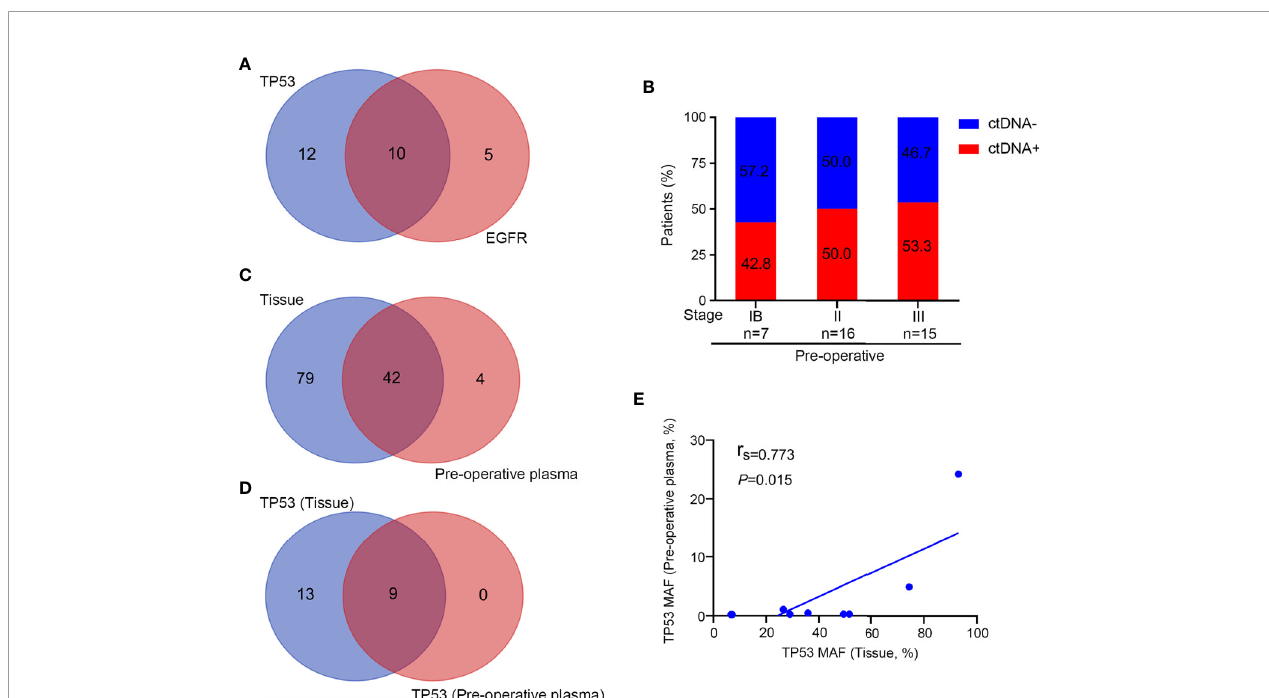
FIGURE 2 | NGS analysis of tissue and preoperative plasma samples. (A) TP53 and EGFR mutation detections in tissue samples. (B) Preoperative detection of ctDNA in different disease stages. (C) The number of detected mutations in tissue and preoperative plasma samples. (D) TP53 mutation detections in tissue and preoperative plasma samples. (E) The association of the mutant allele fraction (MAF) in tumor tissue samples and preoperative plasma samples from patients in whom TP53 mutations were detected in both tissue and plasma samples (n = 9).